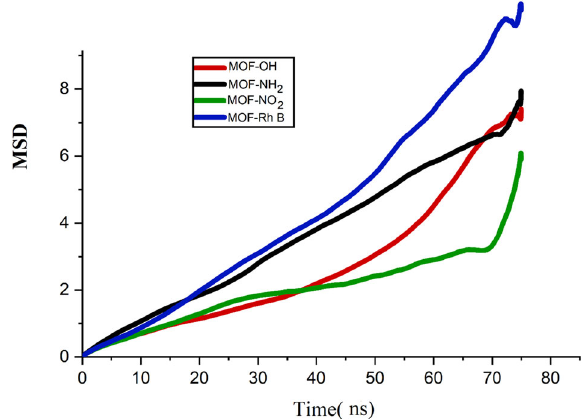
Fig. 5 Time evolutions of MSD of Rh B at the MOF (blue), MOF-NH2 (black), MOF-OH (red), and MOF-NO2 (green) systems.